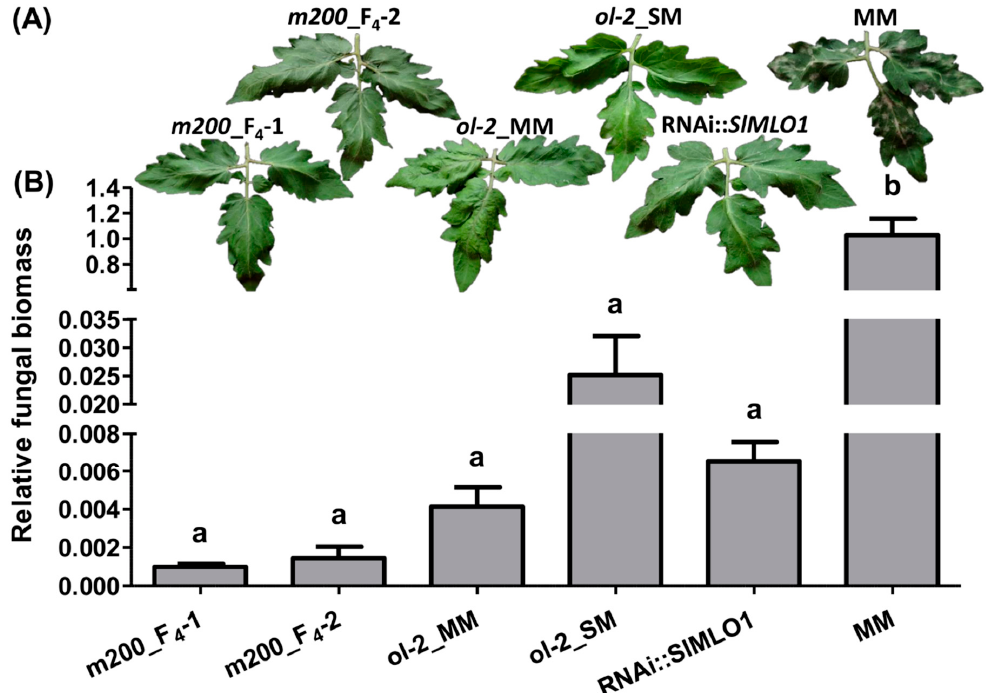
Figure 3. Phenotypic evaluation of the powdery mildew symptoms and relative fungal biomass quantification. Panel ( A ) shows leaves collected 18 days after the pathogen inoculation. Panel ( B ) refers to fungal biomass measured by relative quantification of the ratio between Oidium neolycopersici and plant gDNAs on different genotypes (F 4 plants carrying the m200 allele, plants carrying the ol-2 allele in Moneymaker (MM) and Super Marmande background, a plant carrying the RNAi:: SlMLO1 construct, and MM). Bars show standard errors based on four plants. Columns labeled with different letters are significantly different at p < 0.05 according to Tukey’s multiple comparison test.